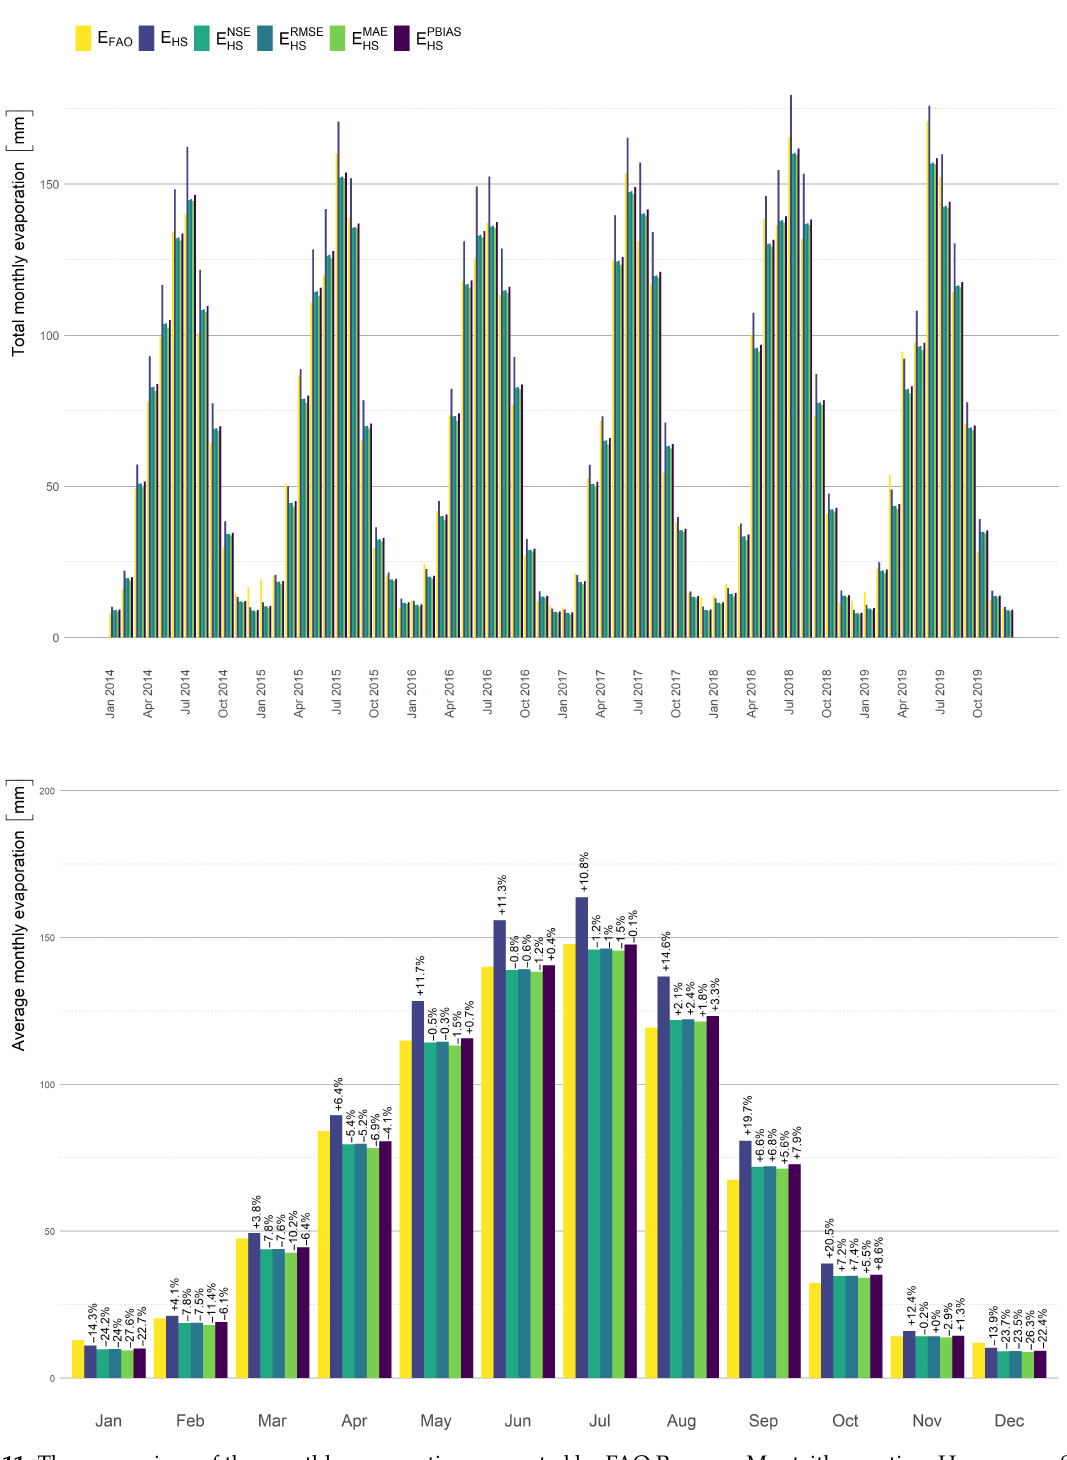
Figure 11. The comparison of the monthly evaporation computed by FAO Penman–Monteith equation, Hargreaves–Samani equation, and calibrated Hargreaves–Samani equation. The calibration has been performed using various stochastic